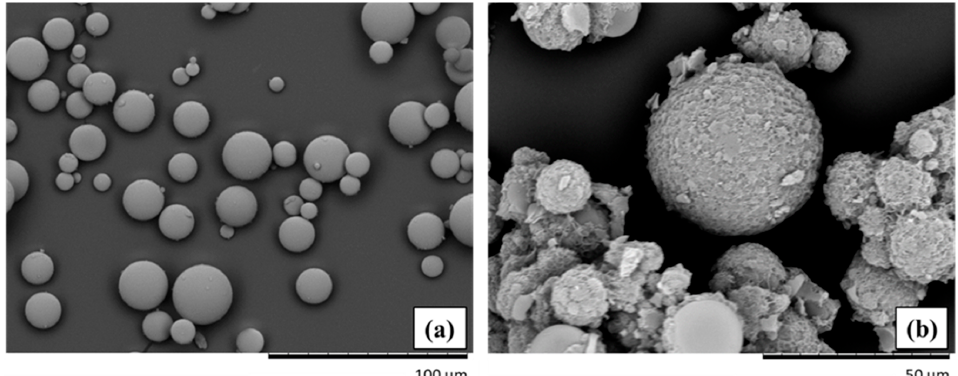
Figure 3. Scanning electron microscopy (SEM) image of HGM alone ( a ) and after surface modification with APTES ( b ).